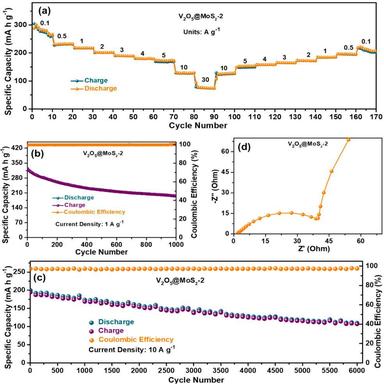
(a) Rate performance at various current densities of 0.1 to 30 A g− 1 , (b, c) long-term cycling stability at 1 A g− 1 and 10 A g− 1 over 1000 and 6000 cycles, respectively, and (d) EIS plots of the V2O5@MoS2–2 NCs cathode.